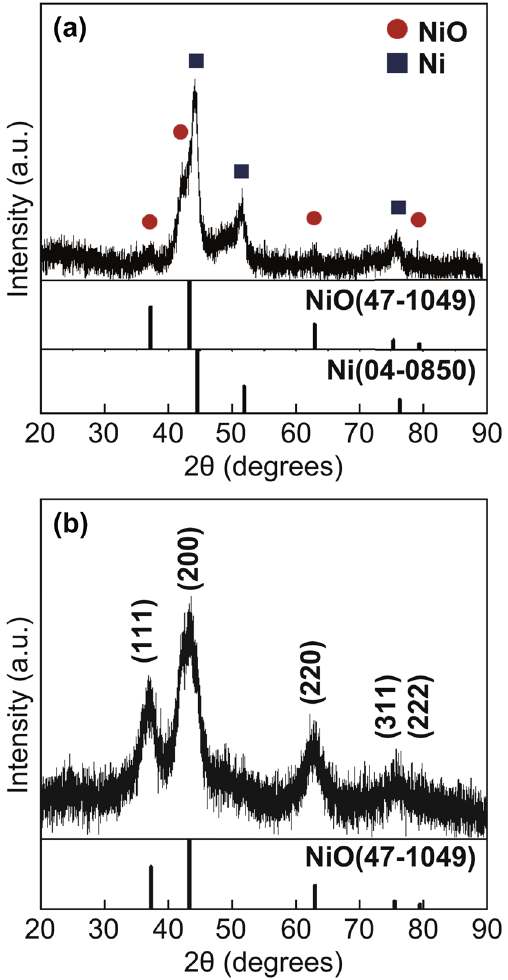
Fig. 4 XRD patterns of the a CYS‑Ni/NiO/C and b CYS‑NiO/C